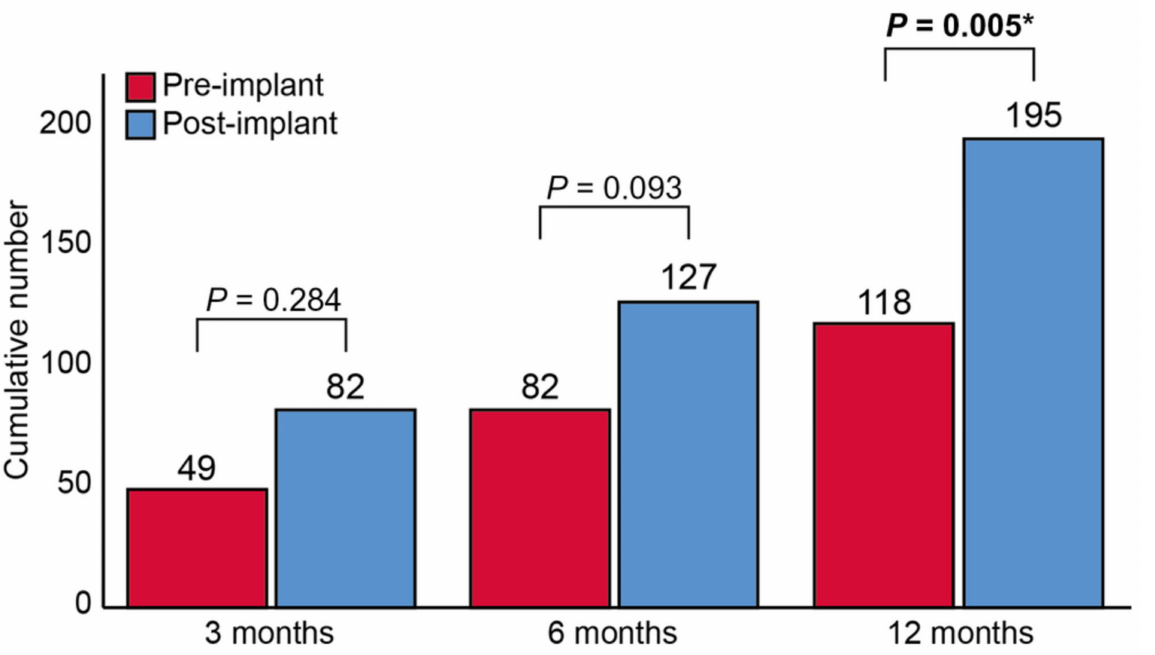
Figure 8. Total number of diuretic changes pre-implantation and post-implantation. Total number of diuretic changes pre-implantation and post-implantation. * p < 0.05. Reprinted from ESC Heart Failure Volume 9, Issue 6, Dauw et al., Ambulatory haemodynamic-guided management reduces heart failure hospitalizations in a multicentre European heart failure cohort, pages 3858–3867, Copyright 2022, with permission from Elsevier